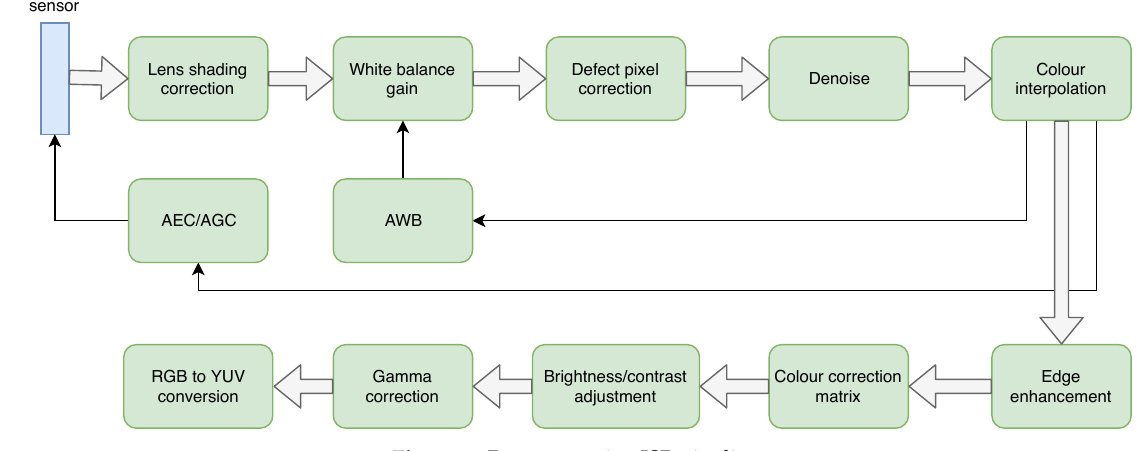
Figure 1. Representative ISP